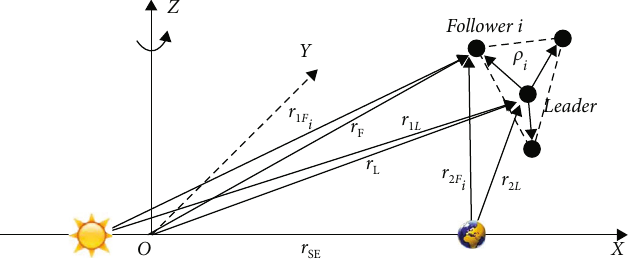
Figure 4: Leader-follower spacecraft